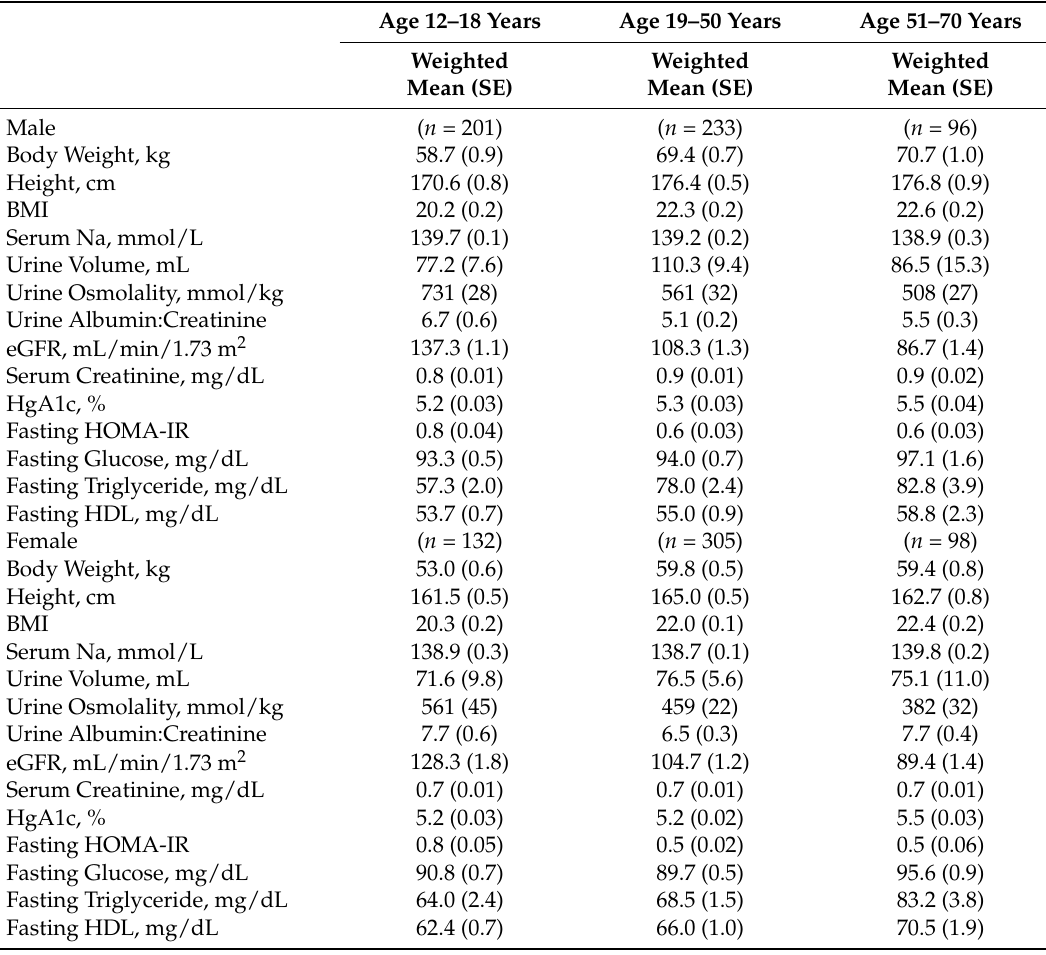
Table 2. Characteristics of the US population sub-group aged 12–70 years in 2009–2012 without selected chronic disease risk